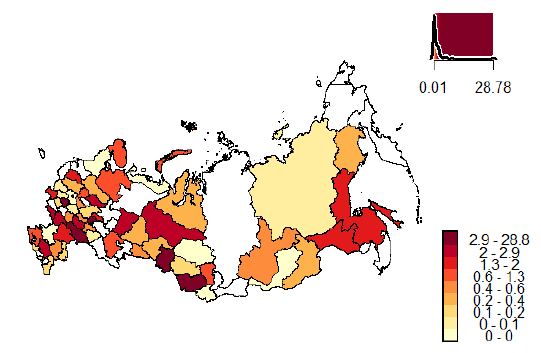
Fig. 2. Distribution of data by subjects of the Russian Federation as a percentage of the total volume of analyzed data. The null hypothesis of the normal distribution was rejected at p <0.05. Comparison of groups of rugby players and patients with diabetes and sarcopenia with the population was carried out using the Multivariate nonparametric rank test (C Sample Test of Location) [12,13]. The analysis was carried out with the help of statistical programming in the R Studio environment using the 'conics' packages by Bernard Desgraupes (University of Paris Ouest — Nanterre, Lab Modal'X (EA 3454)), 'ks' by Tarn Duong, Matt Wand, Jose Chacon, Artur Gramacki, 'nortest' by Juergen Gross, Uwe Ligges, 'energy' by Maria Rizzo, Gabor Szekely, ‘MNM’ by Klaus Nordhausen, Jyrki Mottonen, Hannu